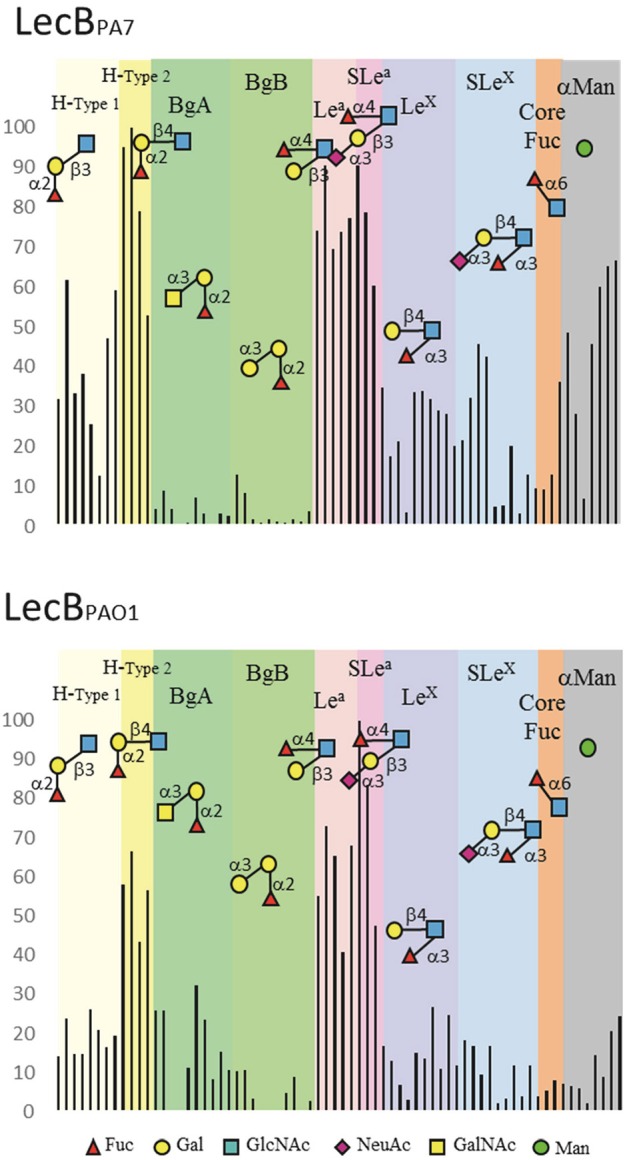
Selected datasets from the glycan array analysis performed on PA7 and PAO1 LecB forms. Binding is represented as relative fluorescent intensities (y-axis) obtained with LecBPA7 (at 200 μg/mL) and LecBPAO1 (at 10 μg/mL) labeled with Alexa 488. A value of 100% is representing the response (RU) for the oligosaccharide with the highest affinity. Oligosaccharides (x-axis) have been grouped using a color code matching blood group families, and a representative molecule was displayed schematically. Yellow: blood group O (sub-type H1 and sub-type H2); Green: Blood group A and Blood group B, Pink: Lewis a and sialyl-Lewis a; Blue: Lewis x and sialyl-Lewis x; Orange: core fucose on N-glycans; Gray: any terminal α-mannose.